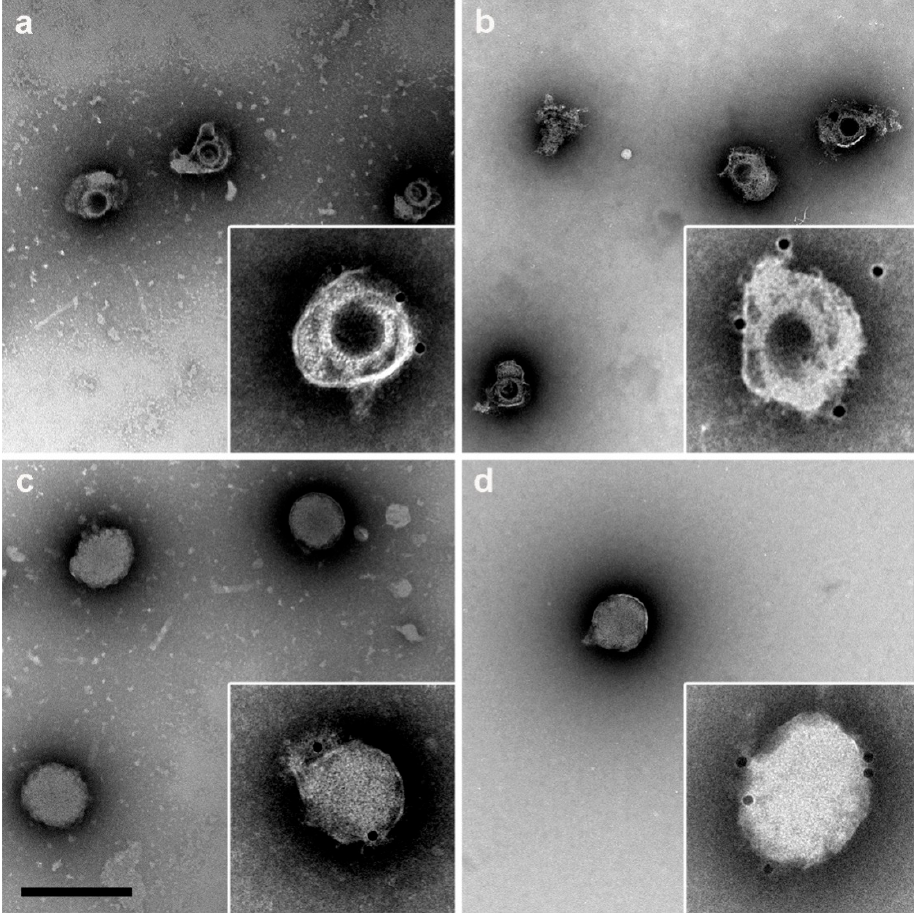
Figure 7. Electron microscopy of CMV assemblies. Transmission electron microscopy of negatively-stained virions ( a , b ) and DB ( c , d ) purified using glycerol-tartrate gradients from MRC-5- ( a , c ) and ARPE-19- ( b , d ) infected cells. The insets show immunoelectron microscopy images of the assemblies labeled with a polyclonal antibody anti-CMV. Bars: 500 nm.